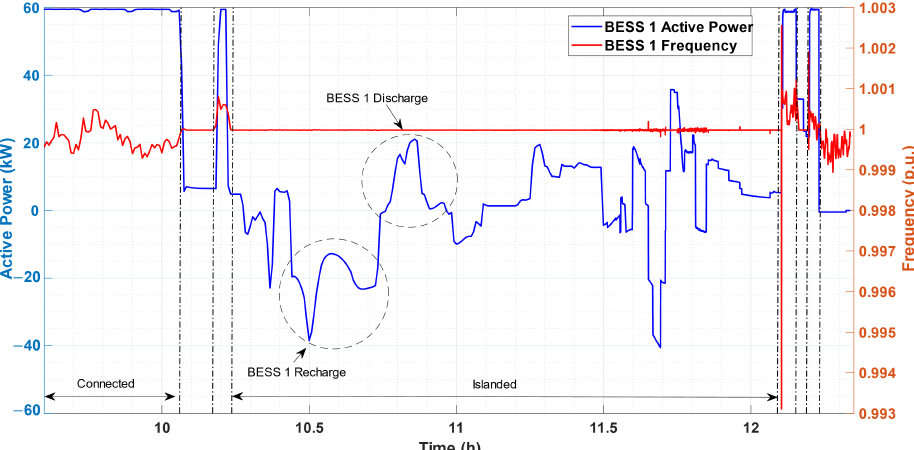
Figure 14. The frequency and active power of BESS 1.